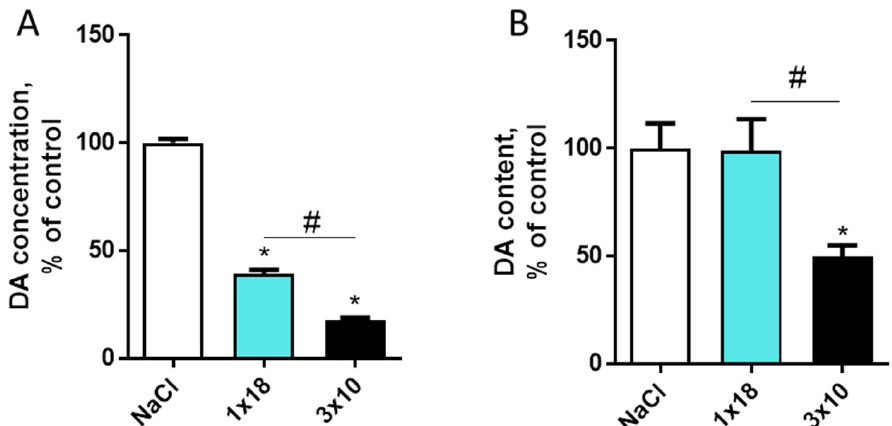
Figure 3. Changes in the dopamine (DA) concentration in the striatum ( A ) and changes in the dopamine content in the substantia nigra ( B ) in mice 2 weeks after subcutaneous administration of 1-methyl-4-phenyl-1,2,3,6-tetrahydropyridine (MPTP): once at a single dose of 18 mg/kg (1 × 18) or three times at a single dose of 10 mg/kg with a 2-h interval between injections (3 × 10), compared to the controls (saline), taken as 100%. * p < 0.05, significant difference compared to the controls, taken as 100%; # p < 0.05, differences between the groups 1 × 18 and 3 × 10.